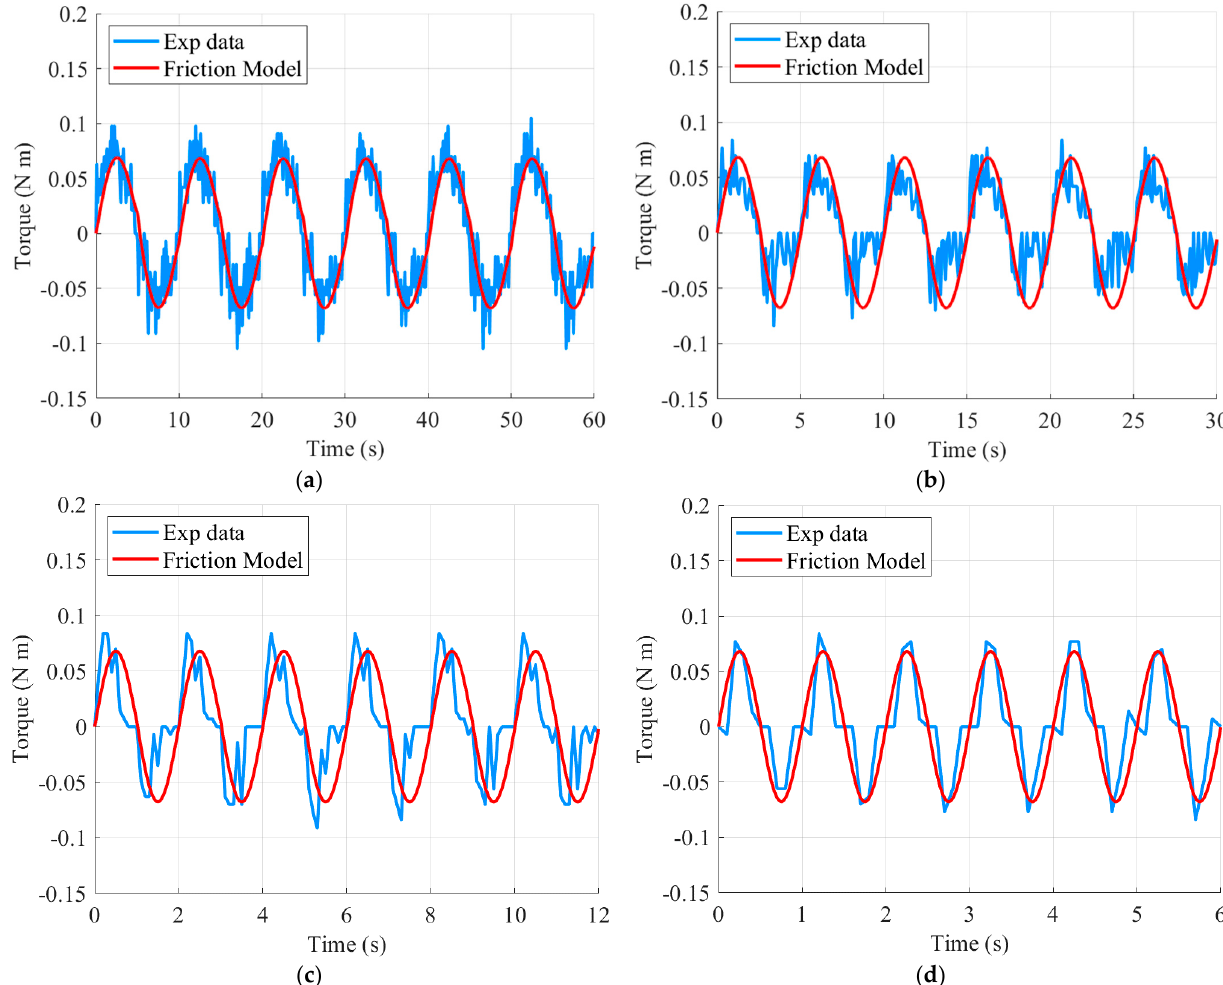
Figure 7. Sinusoidal motion for the dynamic friction model: ( a ) 0.1 Hz; ( b ) 0.2 Hz; ( c ) 0.5 Hz; and ( d ) 1.0 Hz.